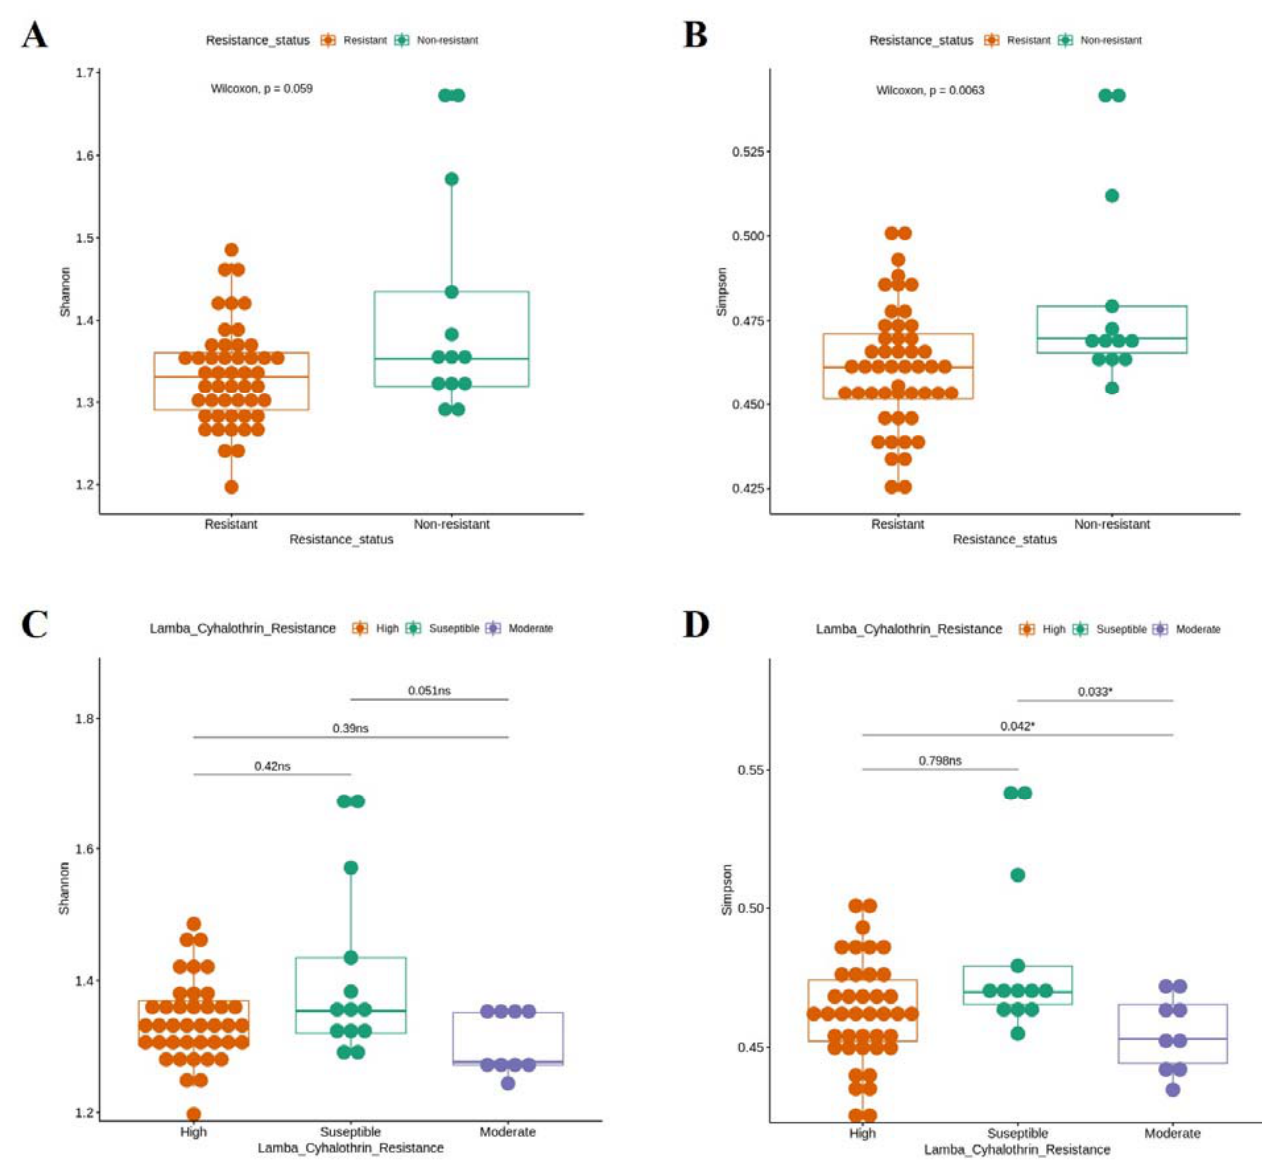
Figure 4. Comparison of bacterial diversity in the midgut of Ae. aegypti among resistant and non-resistant ( A , B ) and highly lambda–cyhalothrin-resistant, susceptible, and moderately resistant populations ( C , D ). Shannon ( A , C ) and Simpson ( B , D ) alpha diversity indices are shown. Wilcoxon rank-sum tests were conducted under R statistical software version 4.1.2. Groups were significantly different when p < 0.05. Table 1. Beta diversity analysis of Ae. aegypti midgut bacteria for ZIKV infection status using the Adonis2 test (* p <